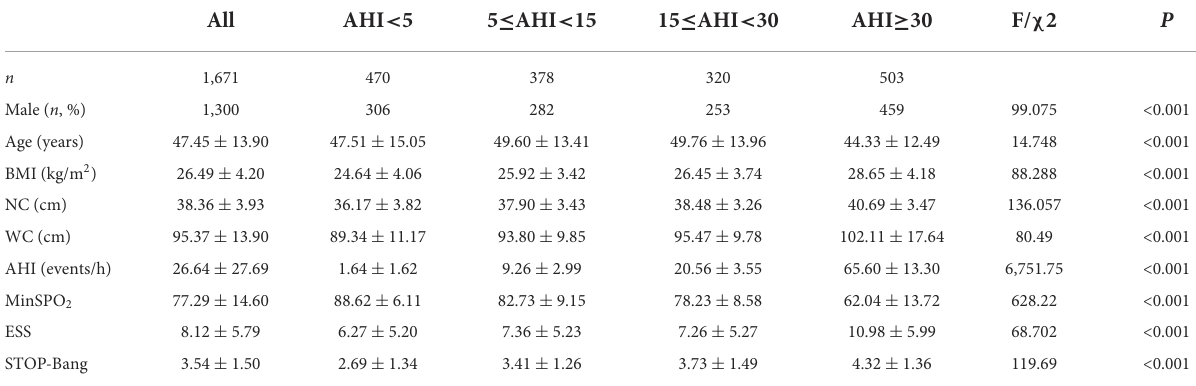
TABLE 1 Baseline characteristics of study subjects.